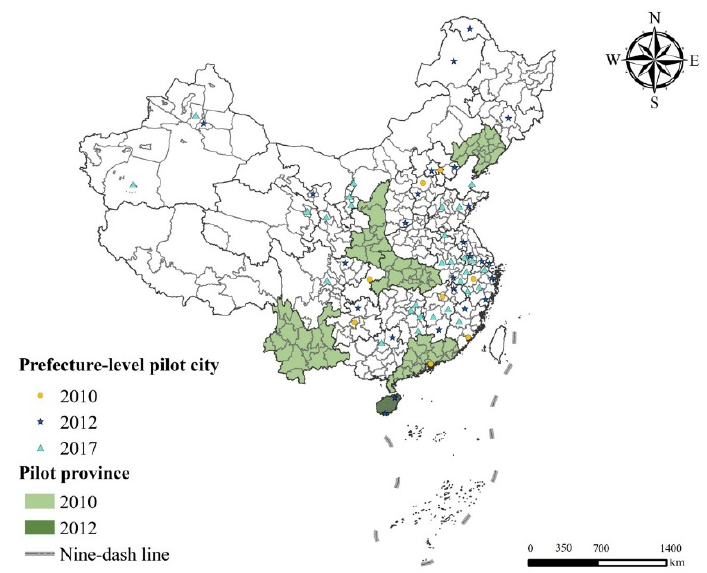
Figure 1. Spatial distribution of three batches of low-carbon pilot areas in China.